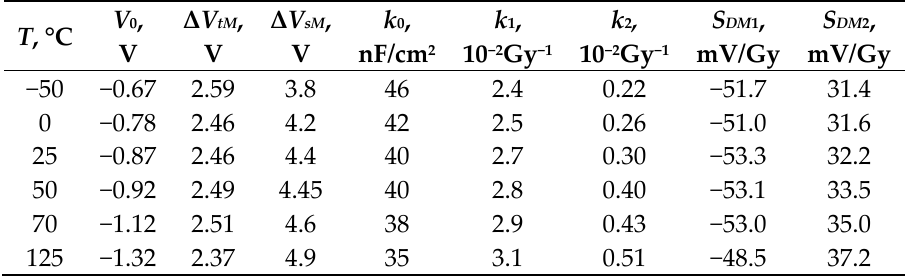
Figure 4. ( a ) I D –V G characteristics for different TID; ( b ) Calculated parameters Δ V t ( D , T ) and Δ V s ( D , T ). Table 1. Average values (dispersion <10%) of parameters of MISFETs and models at I D = 0.1